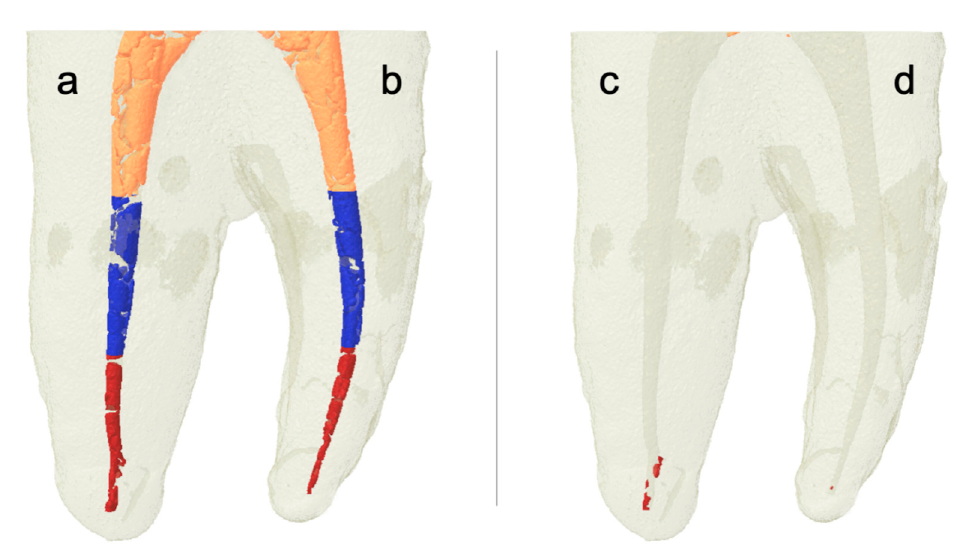
Figure 2. Three-dimensional rendered images constructed from microcomputed tomography (micro- CT) scans of root canals filled with Ca(OH) 2 . After placement ( a , b ); and after removal ( c ) master apical file and syringe irrigation (X3/SI); and ( d ) X3/passive ultrasonic irrigation (PUI). Note that the orange color indicates Ca(OH) 2 in the coronal third, the blue color indicates Ca(OH) 2 in the middle third, and the red color indicates Ca(OH) 2 in the apical third.